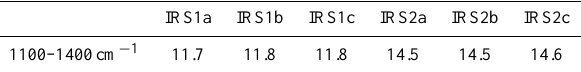
Table 3. Number of degrees of freedom for the retrieval of water vapour profile for the six scenarios, using all channels located in the 1100–1400cm − 1 spectral